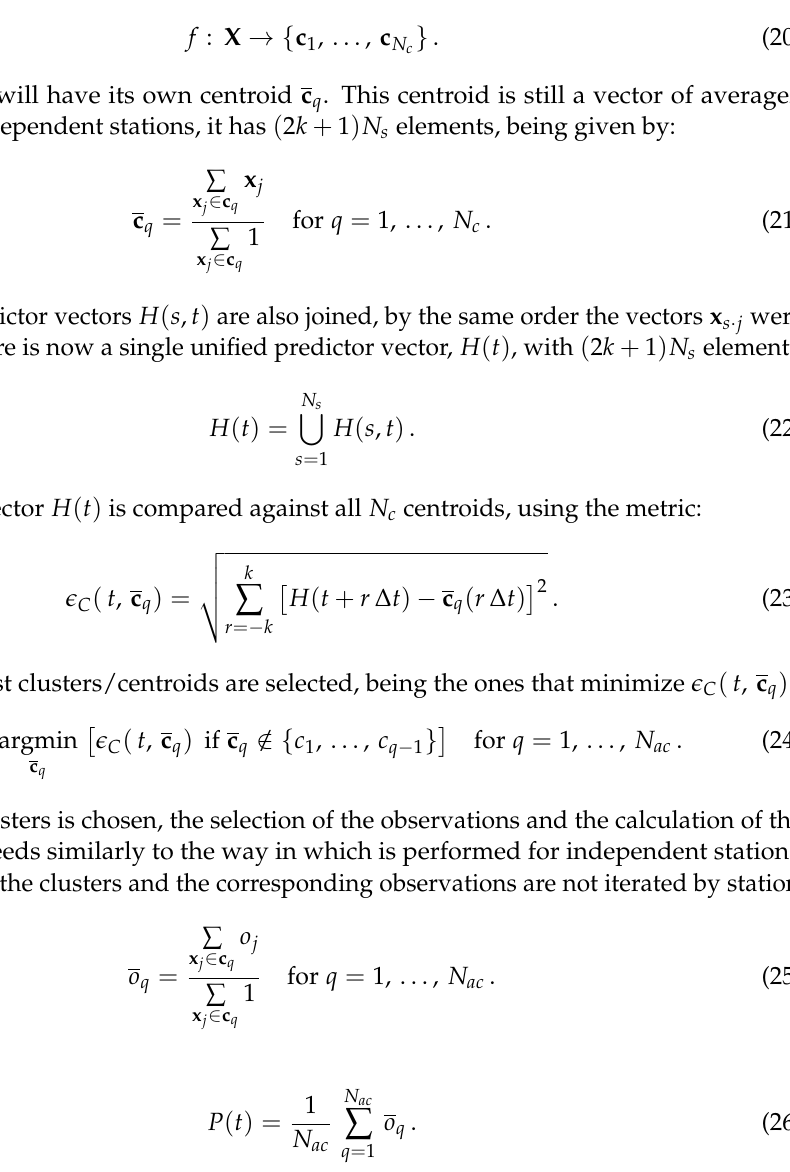
Algorithm 4 resumes the main steps of the cluster-based AnEn method,